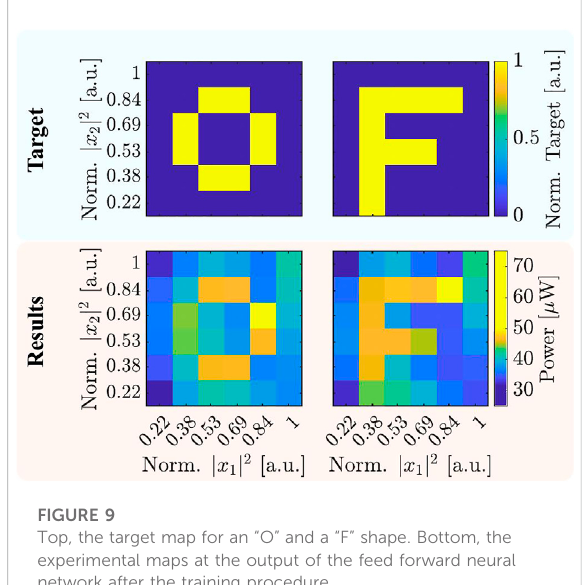
FIGURE 9 Top, the target map for an “ O ” and a “ F ” shape. Bottom, the experimental maps at the output of the feed forward neural network after the training